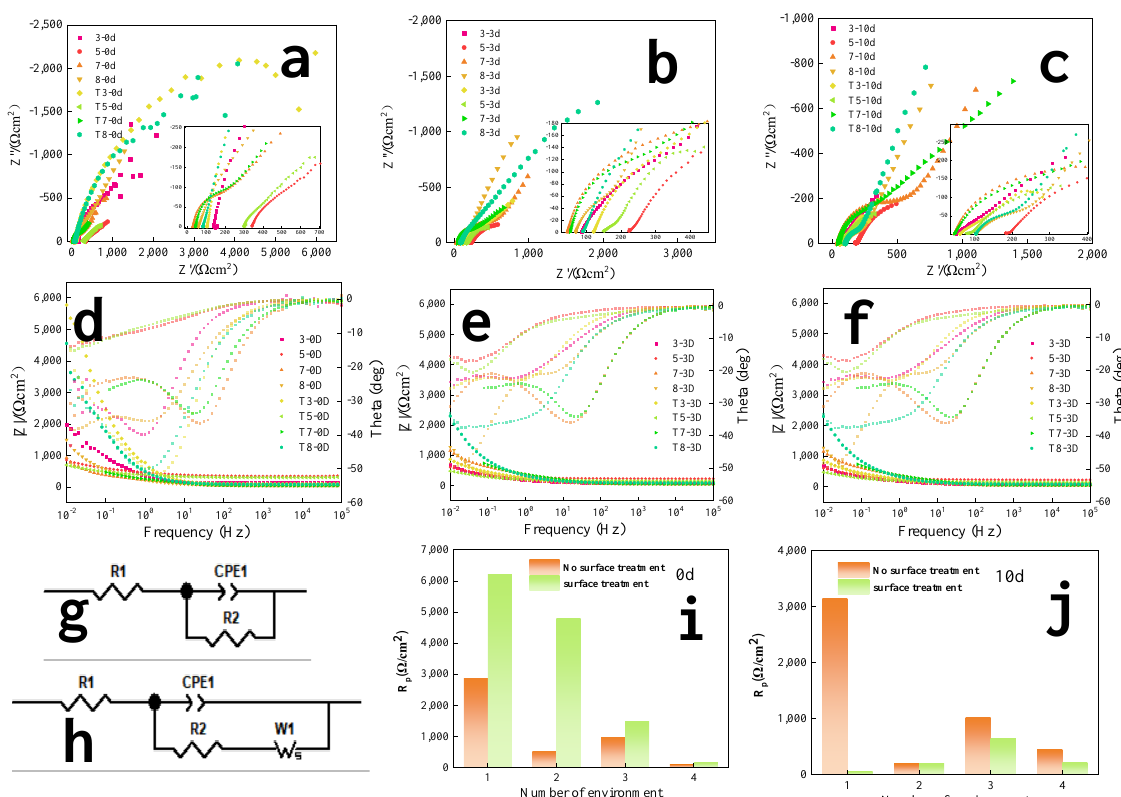
Figure 13. EIS test results. ( a – c ) are nyquist plots, ( d – f ) are bode plots and phase angles, ( g , h ) are the equivalent circuits, ( i , j ) are the comparison fitting results of R P at 0 d and 10 d. The fitted results are shown in Table 3. It can be seen, the charge transfer resistance of the surface-treated ductile iron samples is generally higher at the beginning of the im- mersion process (Figure 13i). As the immersion time increases, the Rp of the surface- treated ductile iron material starts to decrease at 10 d of corrosion. A weaker corrosion inhibition effect was exhibited. This also explains the sudden increase in the i corr of the surface-treated ductile iron at 10 d (Figure 12c). Table 3. Fitting results of R s , R p , and W R by EIS. Times(d)